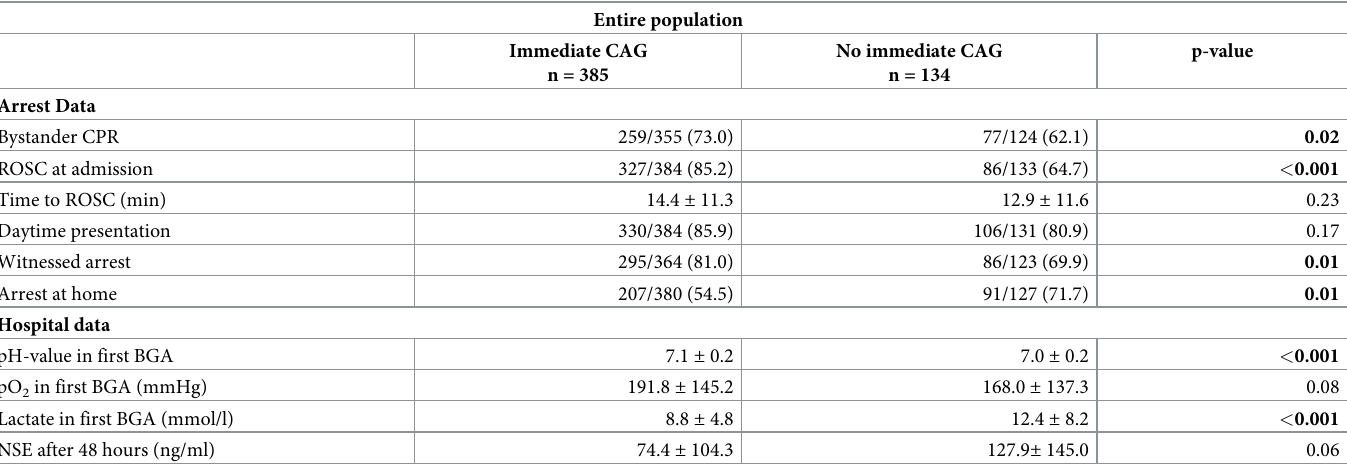
Table 4. Preclinical and hospital data of patients with and without immediate CAG.